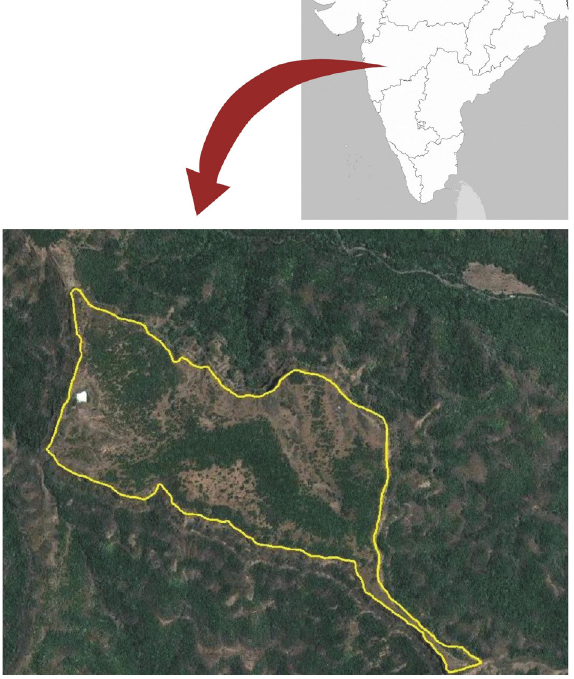
Figure 1. The study site, Rangana, Maharashtra, India (Source: Google Maps)